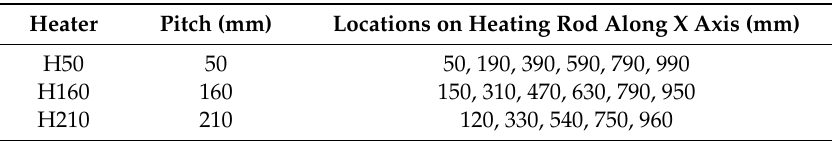
Table 1. Parameters of heating rod temperature